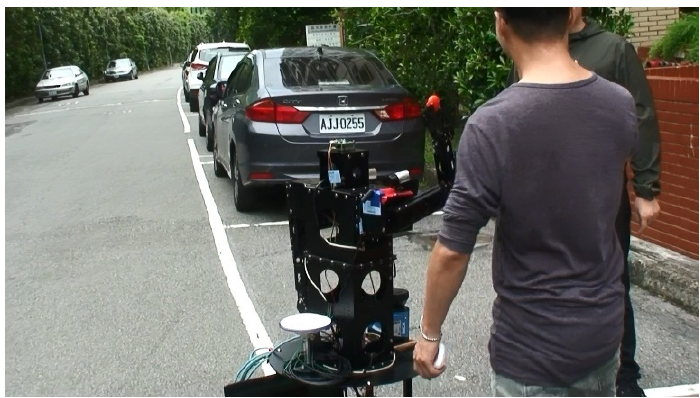
Figure 32. Personnel from the control center went to turn off the alarm.